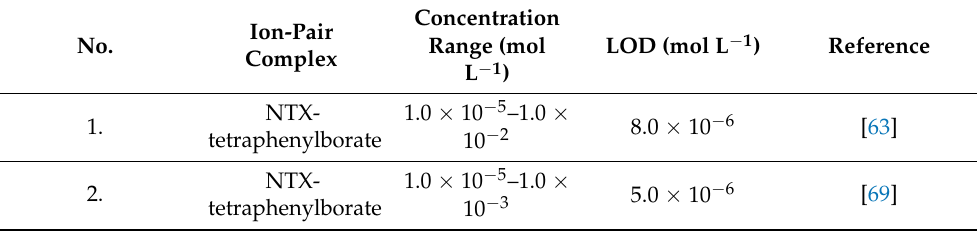
Table 7. Comparative study between the suggested modified NTX-TPB-CuO/Al 2 O 3 nanocomposite sensor and the previously potentiometric reported